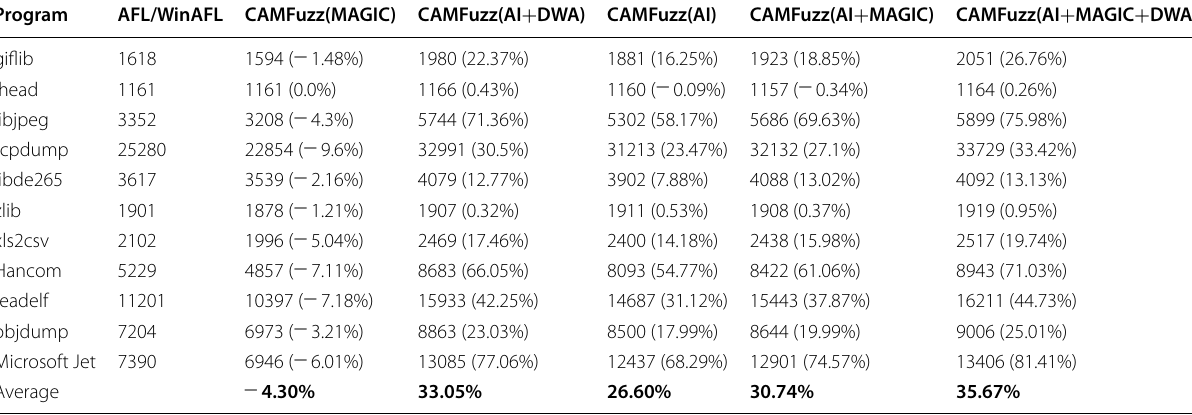
Table 5 Contribution of different components (basic blocks in 24 h) Program